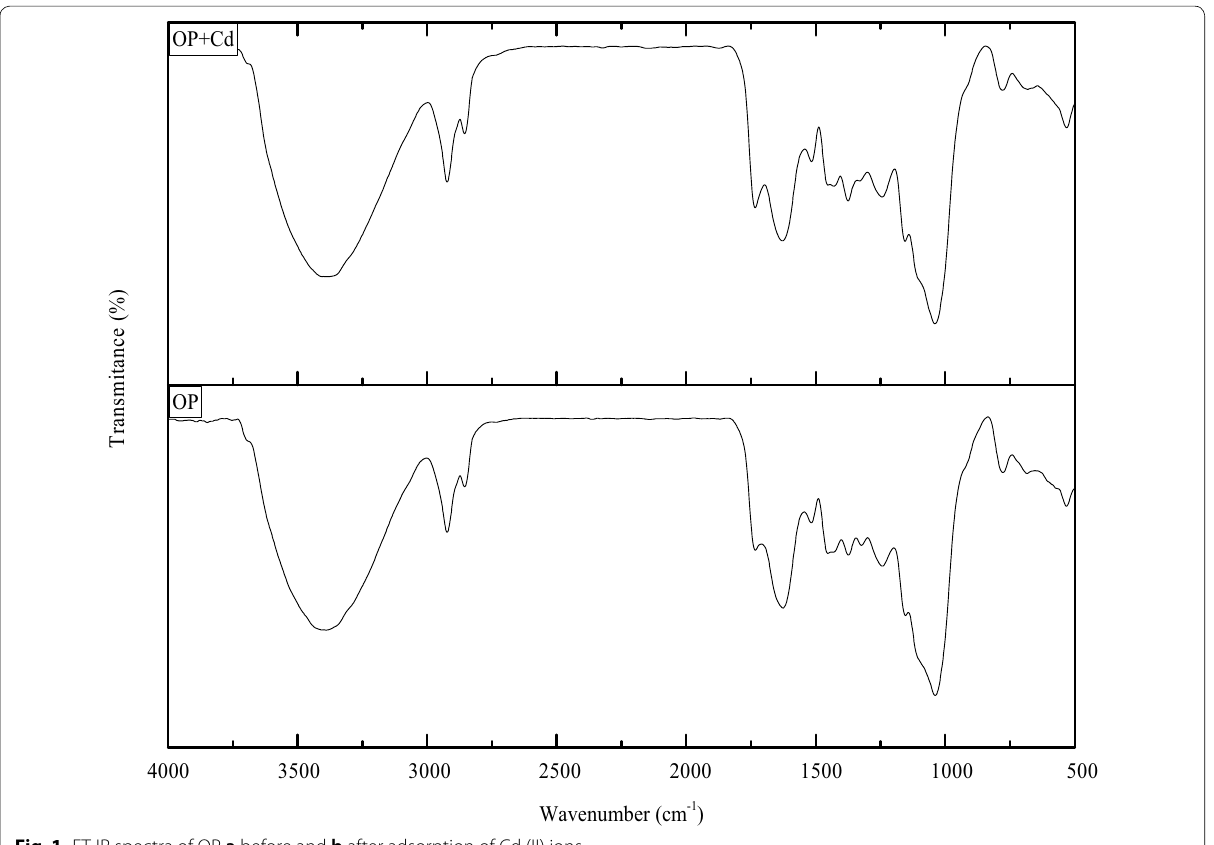
Fig. 1 FT-IR spectra of OP a before and b after adsorption of Cd (II)